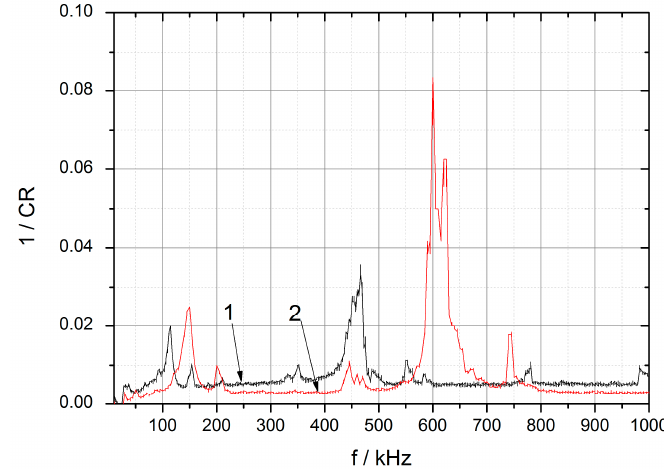
Figure 5. The dependences of Pockels cell BBO crystals contrast ratio on applied high-voltage pulse frequency for crystals with various dimensions: 1—4 × 4 × 25 mm; 2—3 × 3 × 25 mm.